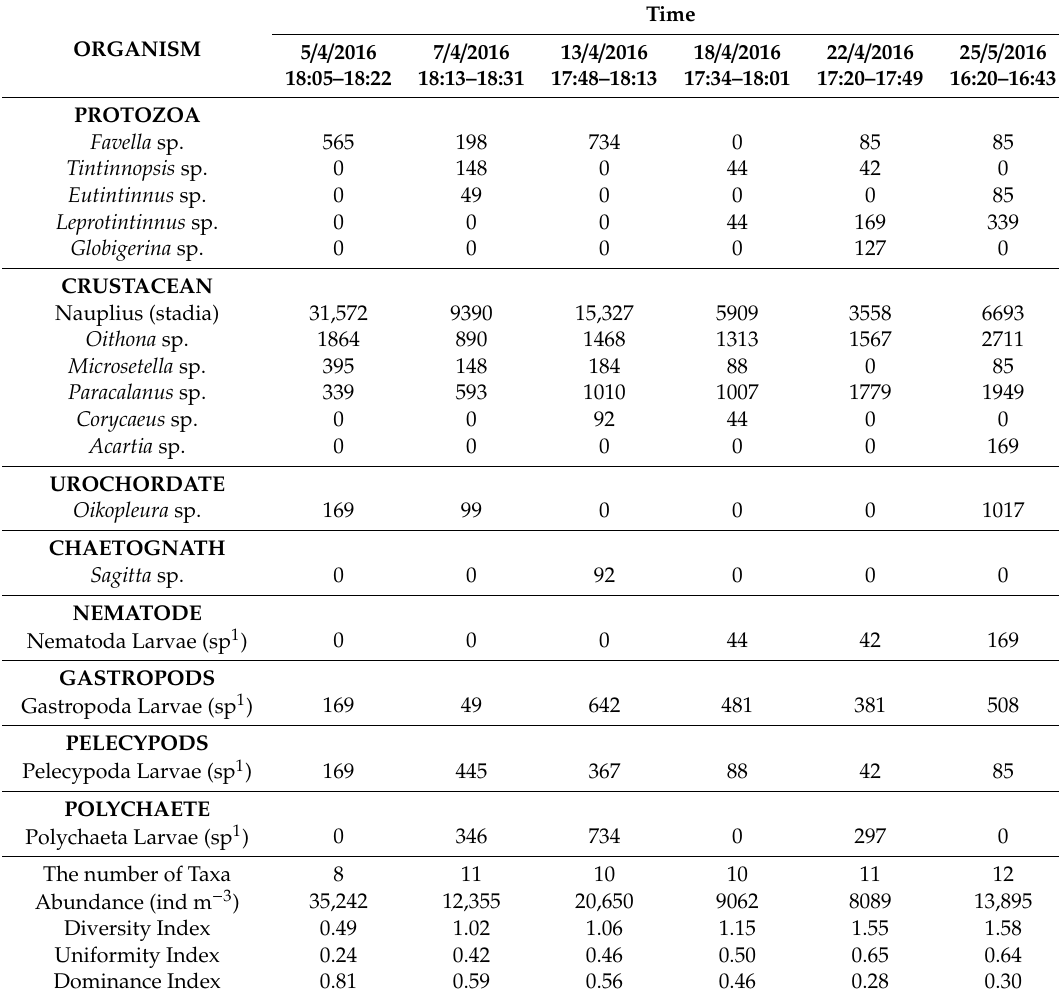
Table 2. The abundance of zooplankton (ind m − 3 ) based on laboratory analysis for 6-day